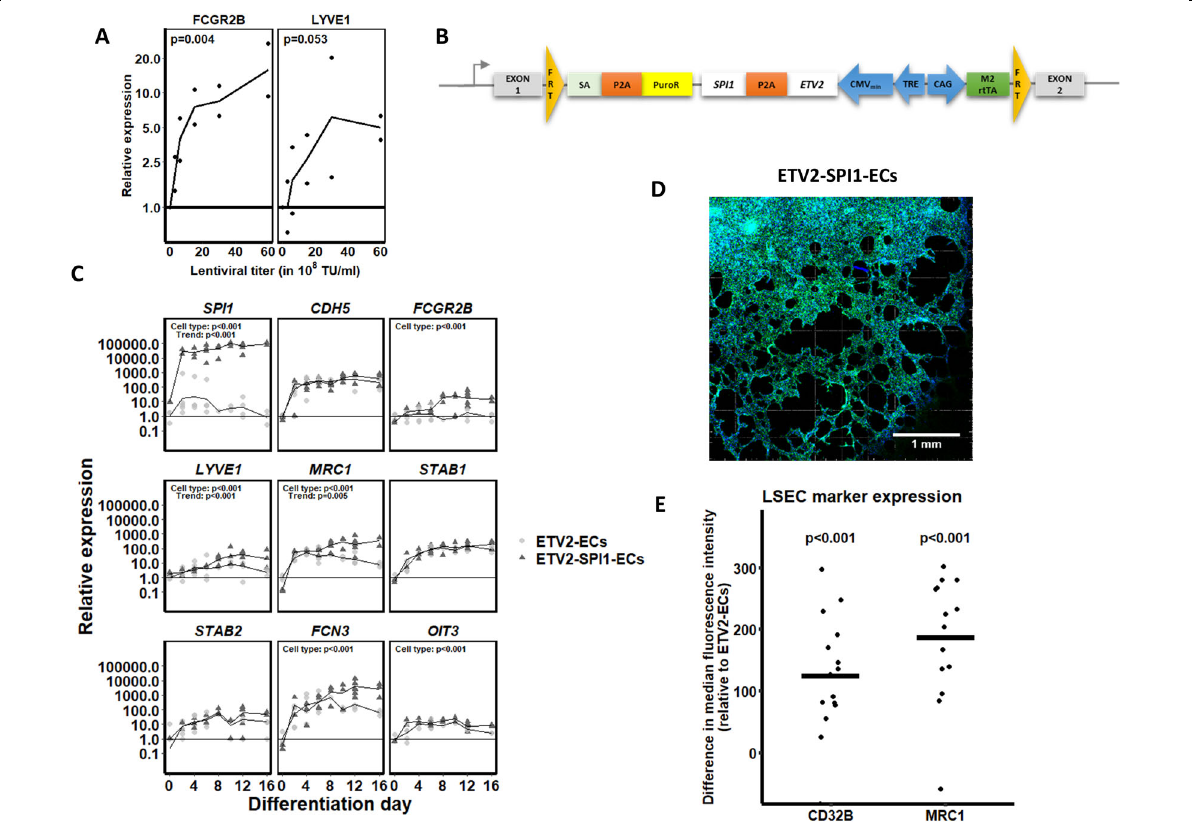
Fig. 6 Characterisation of (liver sinusoidal) endothelial cell markers in ETV2-ECs and ETV2-SPI1-ECs. A ETV2-ECs were transduced on day 6 of differentiation with increasing titres of the SPI1 -encoding lentiviral vector. The effect of SPI1 overexpression on the LSEC markers FCGR2B and LYVE1 is shown. Statistical analysis by linear modelling (expression ~ titre); N = 2 biological replicates per concentration. B ETV2-SPI1 construct engineered into the AAVS1 safe harbour locus. Recombination was performed analogously to Fig. 1A. (FRT Flippase recognition target, SA splice acceptor, PuroR puromycin resistance gene, TRE tetracycline response element, M2rtTA M2 reverse tetracycline transactivator). C Time-course comparison between ETV2-ECs and ETV2-SPI1-ECs for the overexpressed SPI1 , for the endothelial cell-speci fi c gene CDH5 , for the known LSEC markers FCGR2B , LYVE1 , MRC1 , STAB1 , and STAB2 , and for novel LSEC markers, such as FCN3 , and OIT3 . Statistical signi fi cances were assessed by mixed ANOVA. Undetected mRNA values were represented with a relative expression of 1. The x -axes denote the days of differentiation. The differentiation protocols for ETV2-ECs and ETV2-SPI1-ECs are identical. D Tube formation assay on day 12 of differentiation of ETV2-SPI1-ECs. E LSEC marker expression (CD32B and MRC1) in ETV2-SPI1-ECs compared to ETV2-ECs. Chart indicates the median fl uorescence intensity shift for CD32B and MRC1 of ETV2-ECs and ETV2-SPI1-ECs on day 12 of differentiation (replicates: N = 15 for CD32B and N = 14 for MRC1). The CD32 and MRC1 positive cells were gated from single-cell, PI- negative, and VE-cadherin-positive populations (gating strategy in Supplementary Fig.